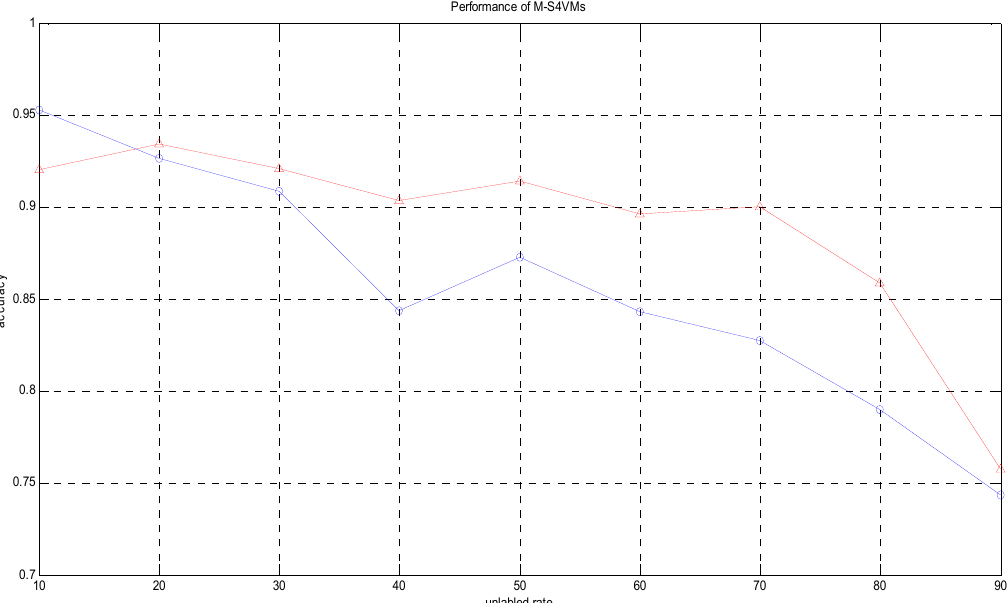
Figure 7. Performance of M-S4VMs with different unlabeled rates. Note: Data1 (blue) represents the accuracy of the first classification without unlabeled sample, and data2 (red) represents the accuracy of M-S4VMs with unlabeled sample in the second classification.